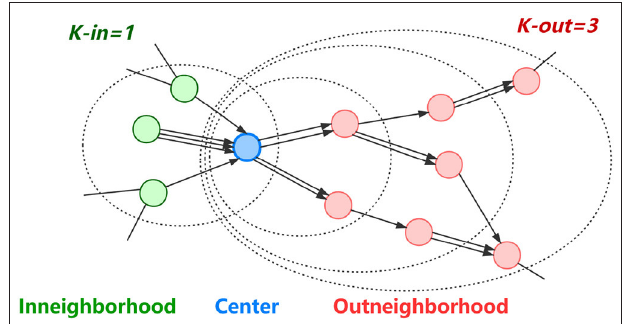
FIGURE 3 | Schematic illustration of a directed K -order subgraph for phishing